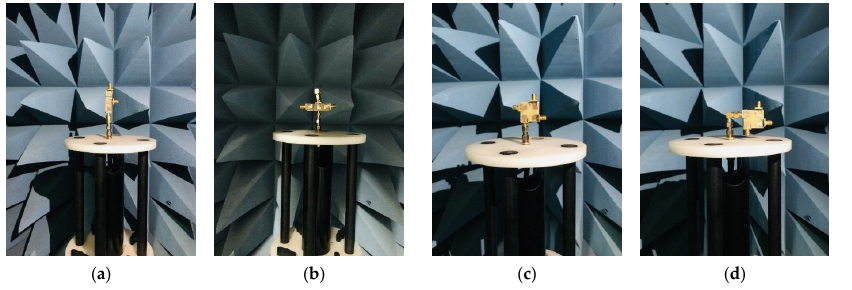
Figure 16. Radiation pattern measurement setup in anechoic chamber: ( a ) three-element E plane; ( b ) three-element H plane; ( c ) four-element E plane; ( d ) four-element H plane.